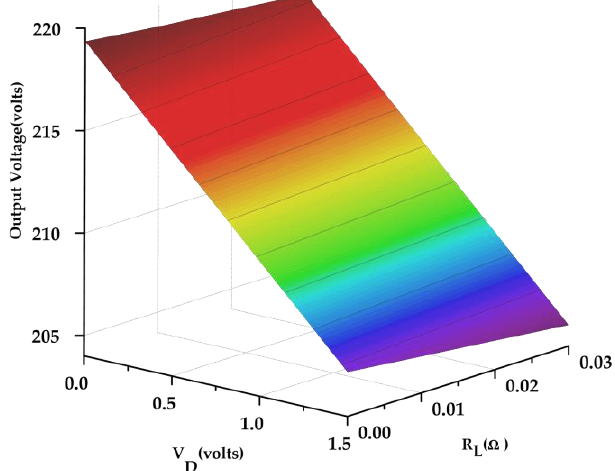
Figure 8. Variation in the theoretical output voltage with changes in V D and r L.